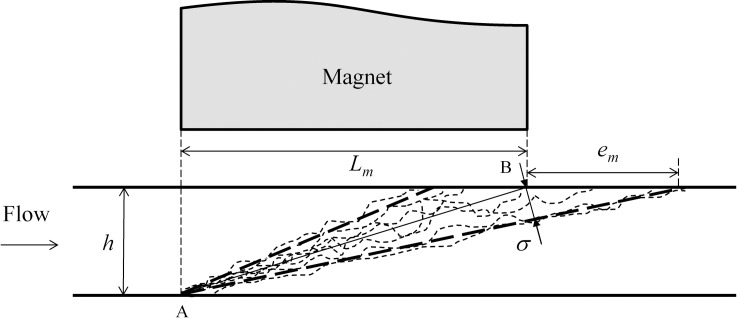
Sketch of the paths of a particle located at the bottom of the microchannel (point A).